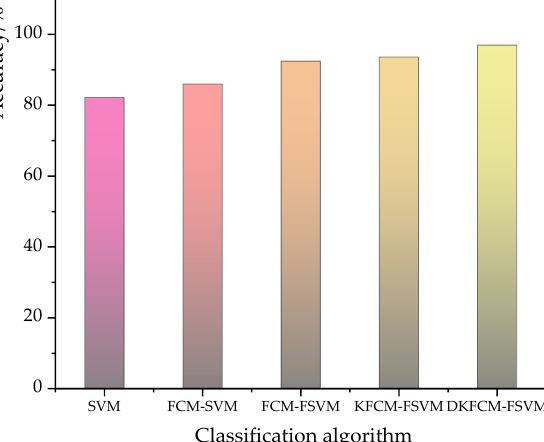
Figure 10. The overall detection accuracy of the wireless sensor network algorithm models.